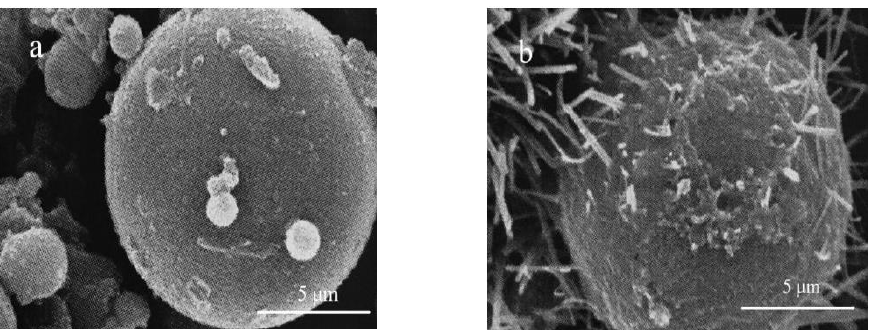
Figure 17. SEM images of fly ash particles [74]: ( a ) without desulfurized gypsum; ( b ) with desulfurized gypsum.